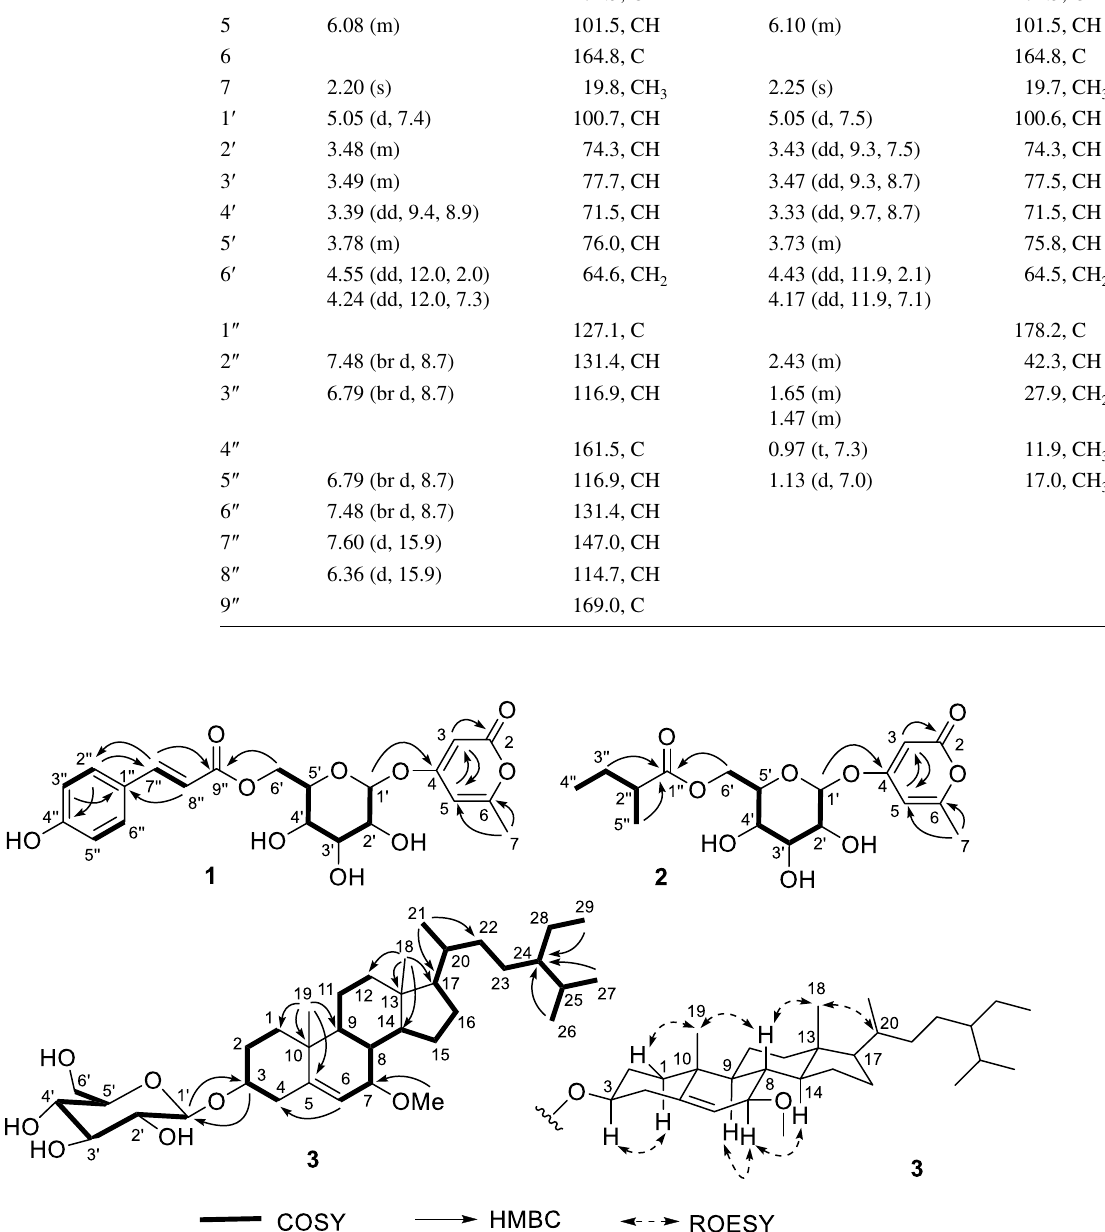
data of 2 (Table 1) indicated the presence of one 6-methyl-